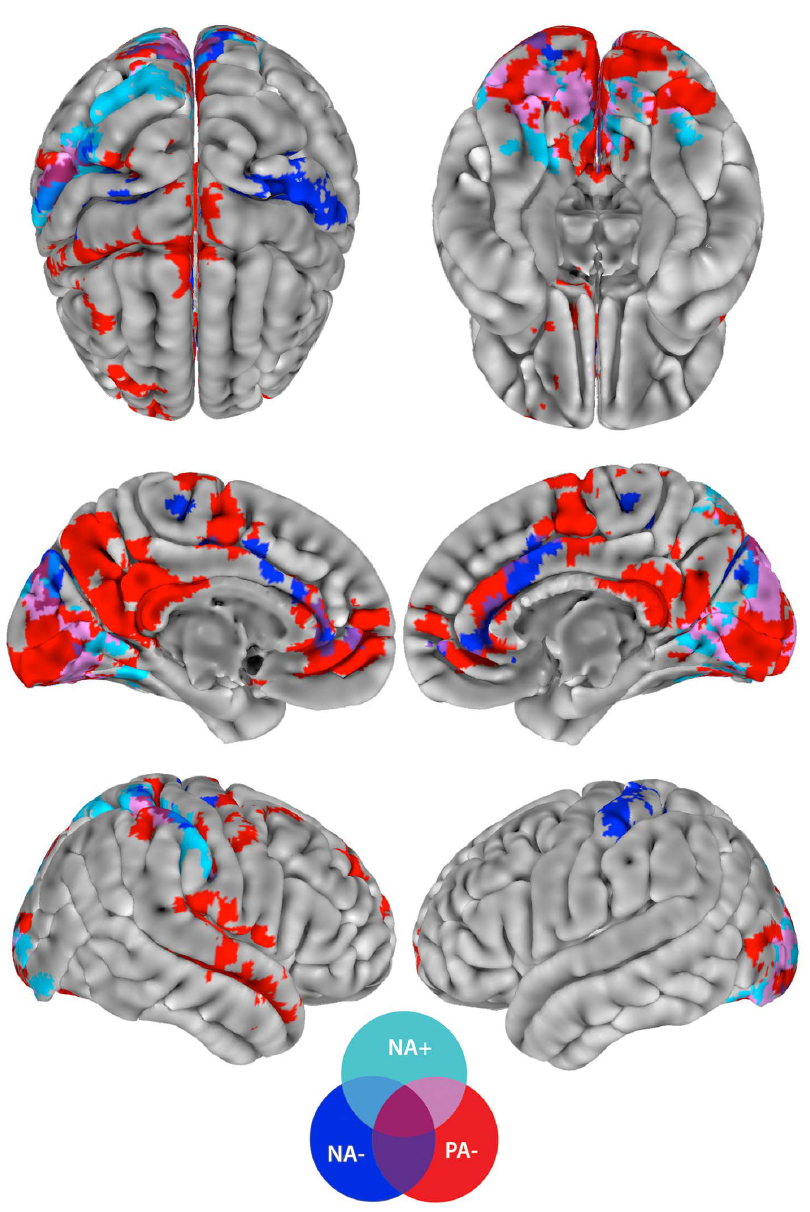
Figure 5. Networks correlated with Positive Affect (PA) and Negative Affect (NA). Whole-brain connectivity analysis revealed networks that were correlated with PA or NA. While some of the regions were common to both PA and NA functional connectivity patterns, others were dissociative of the respective affective domain, here depicted in different colors. A trend for overall right-hemispheric dominance was observed.